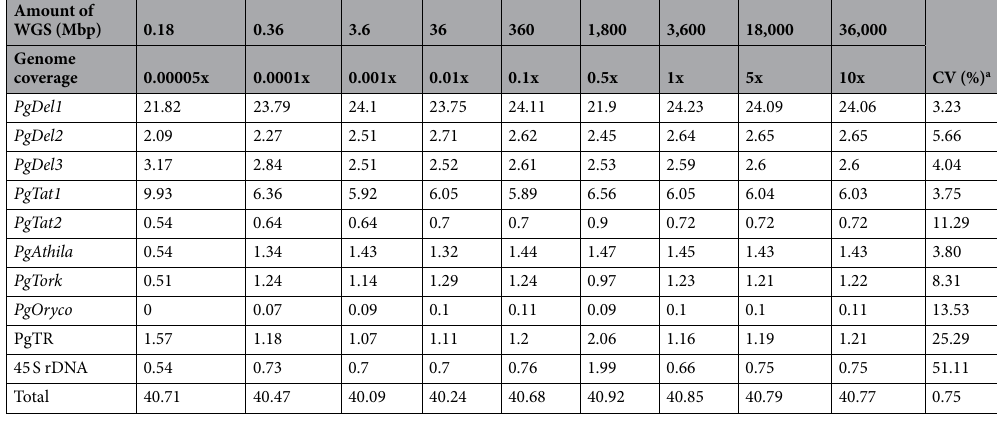
Table 1. Summary of GP calculation for major repeats in WGS data sets with various genome coverage of P . ginseng cv. Chunpoong. a CV: coefficient of variation. CV values were calculated for the GP values using 0.0001x- 10x genome coverage WGS, except the GP for